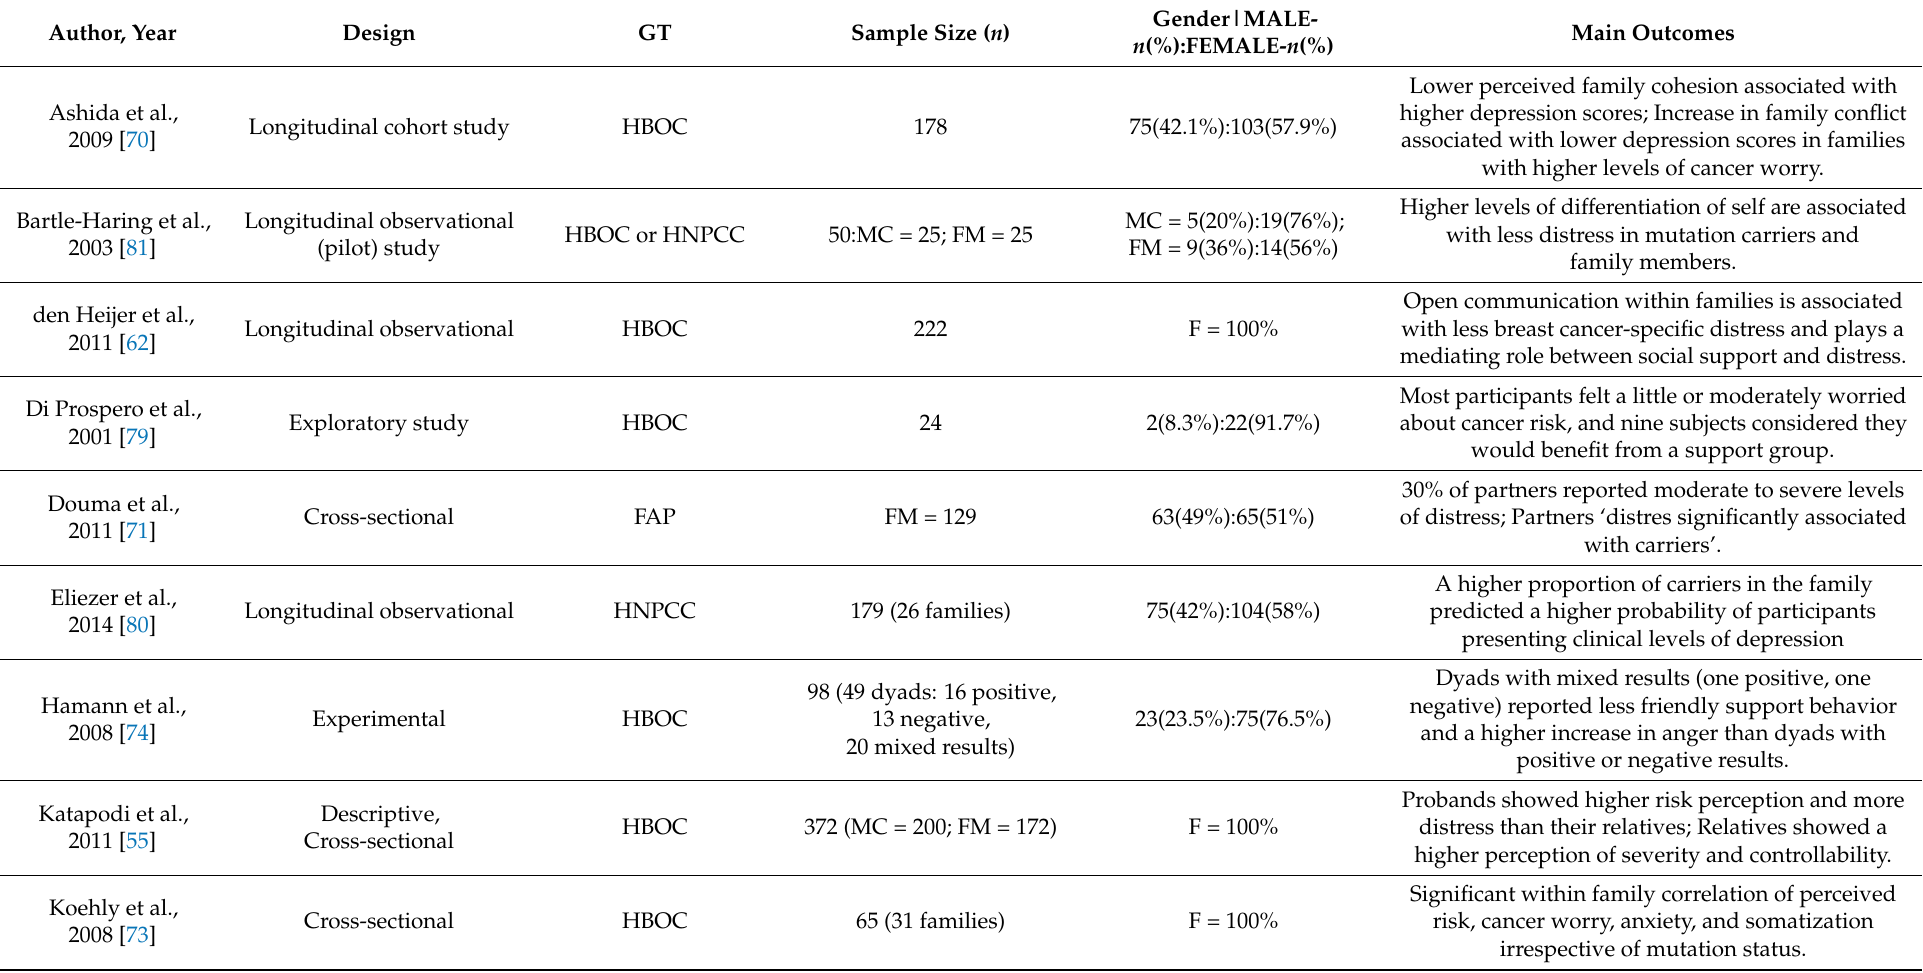
Table 1. Characteristics of the included studies